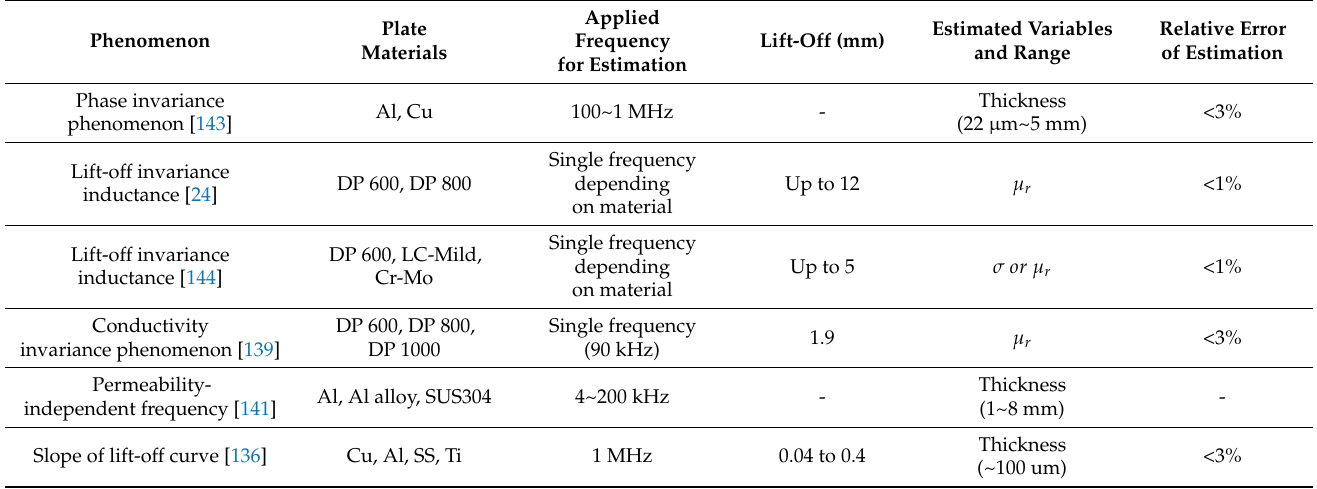
Table 8. Experimental evaluation of plate property estimation employing the representative coil inductance